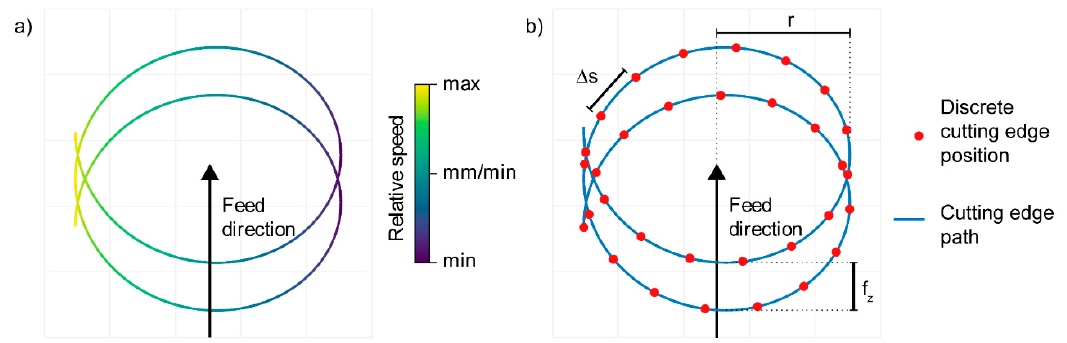
Figure 9. The travelled path of one cutting edge during two consecutive feeds. ( a ) Relative speed pointing in feed direction during tool rotations. ( b ) Cutting edge positions based on the spr discretization.